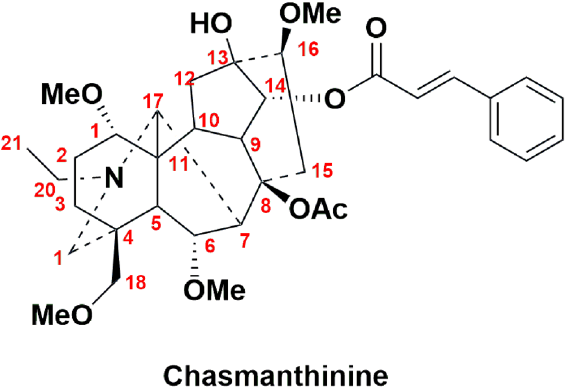
Figure 1. Structure of